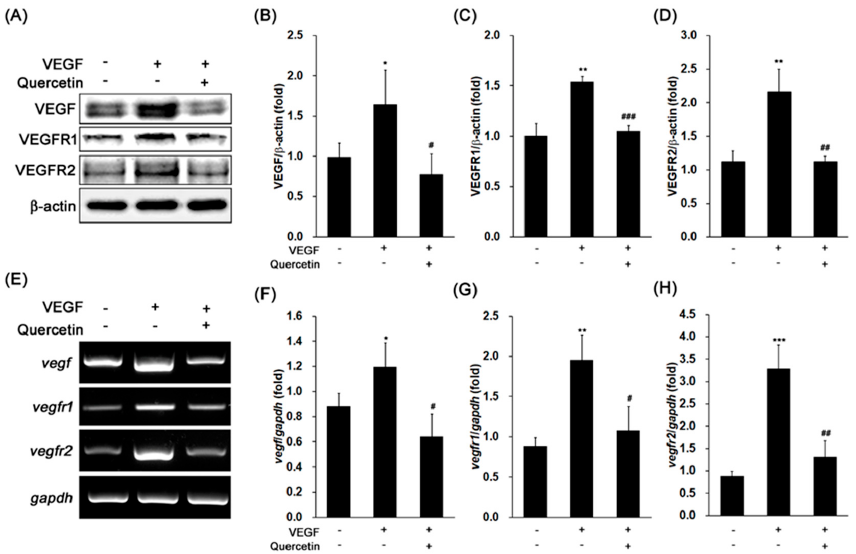
Figure 2. Effect of quercetin on the expression of vascular epithelial growth factor (VEGF), VEGFR1, and VEGFR2 in VEGF-stimulated 661W cells. ( A ) Cells were treated with VEGF (20 ng/mL) in the absence or presence of quercetin (0.1 µM) for 16 h. The protein expression was detected by immunoblot. ( B – D ) Densitometry quantifications of VEGF ( B ), VEGFR1 ( C ), and VEGFR2 ( D ) protein expression were measured by ImageJ. Data are the means ± SDs of three independent experiments. * p < 0.05 and ** p < 0.01 indicate significant differences compared to the non-treated control group. # p < 0.05, ## p < 0.01 and ### p < 0.001 indicate significant differences compared to the VEGF-only treated group. ( E ) Cells were treated with VEGF (20 ng/mL) in the absence or presence of quercetin (0.1 µ M) for 6 h. Gene expression was determined by RT-PCR. ( F – H ) Densitometry quantifications of vegf ( F ), vegfr1 ( G ), and vegfr2 ( H ) gene expression were measured by ImageJ. Data are the means ± SDs of three independent experiments. * p < 0.05, ** p < 0.01, and *** p < 0.001 indicate significant differences compared to the non-treated control group. # p < 0.05 and ## p < 0.01 indicate significant differences compared to the VEGF-only treated